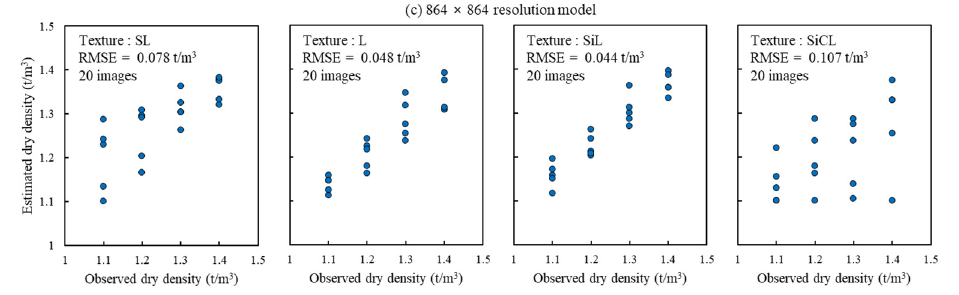
Figure 13. Quantitative results of soil dry density prediction by the convolutional neural network model.